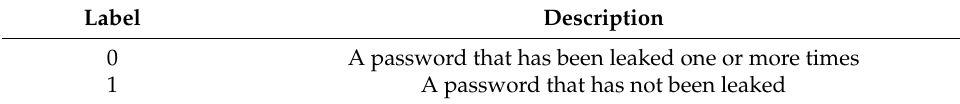
Table 2. Password label data